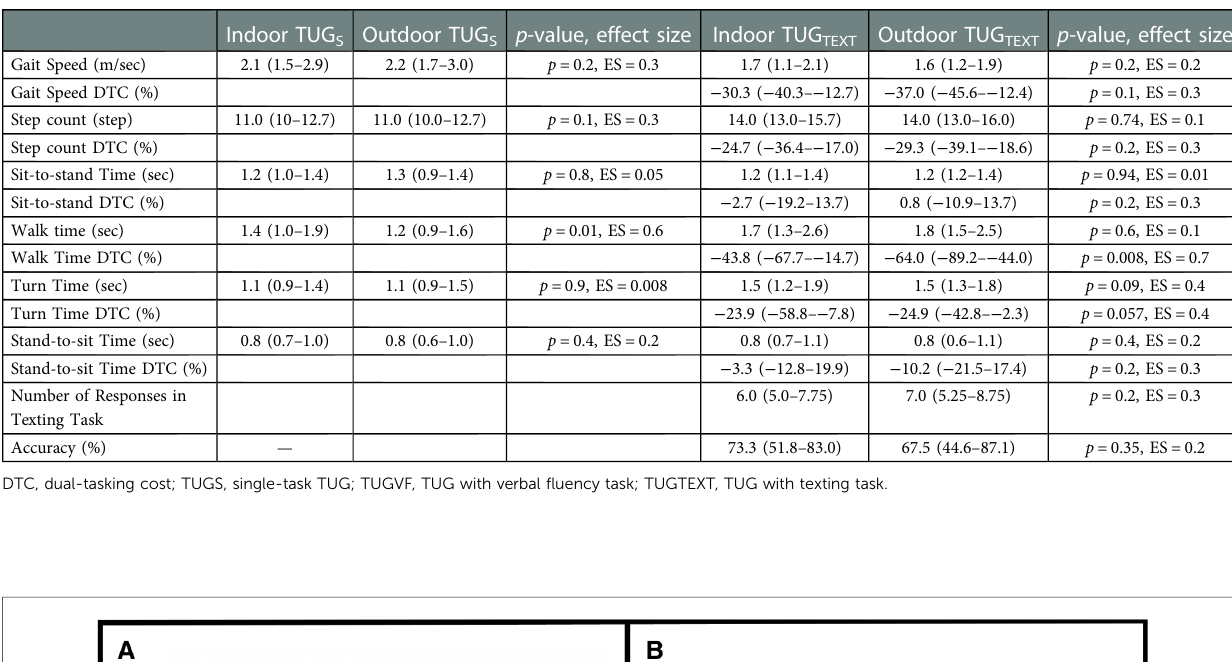
TABLE 2 Median (interquartile range) values are presented for the dependent variables across indoor and outdoor.